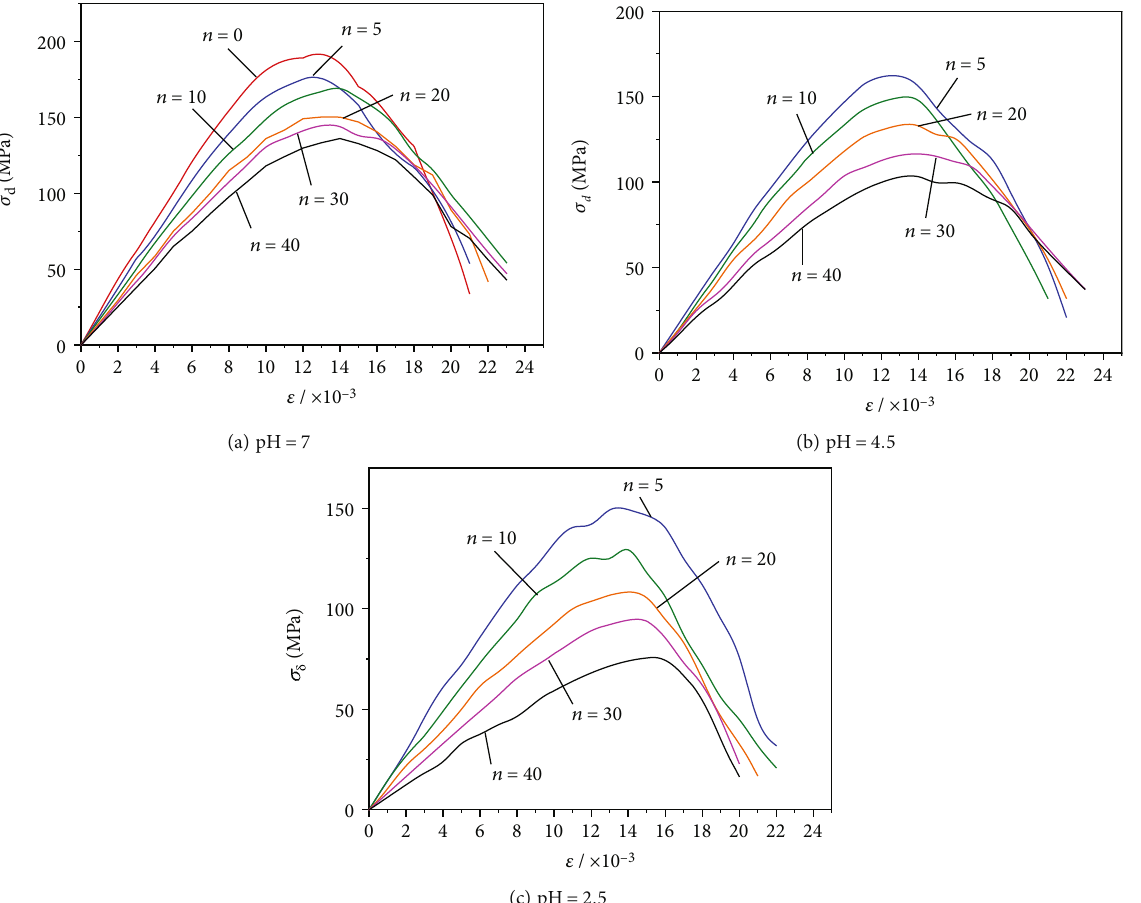
Figure 3: Dynamic stress-strain curve of red sandstone under di ff erent